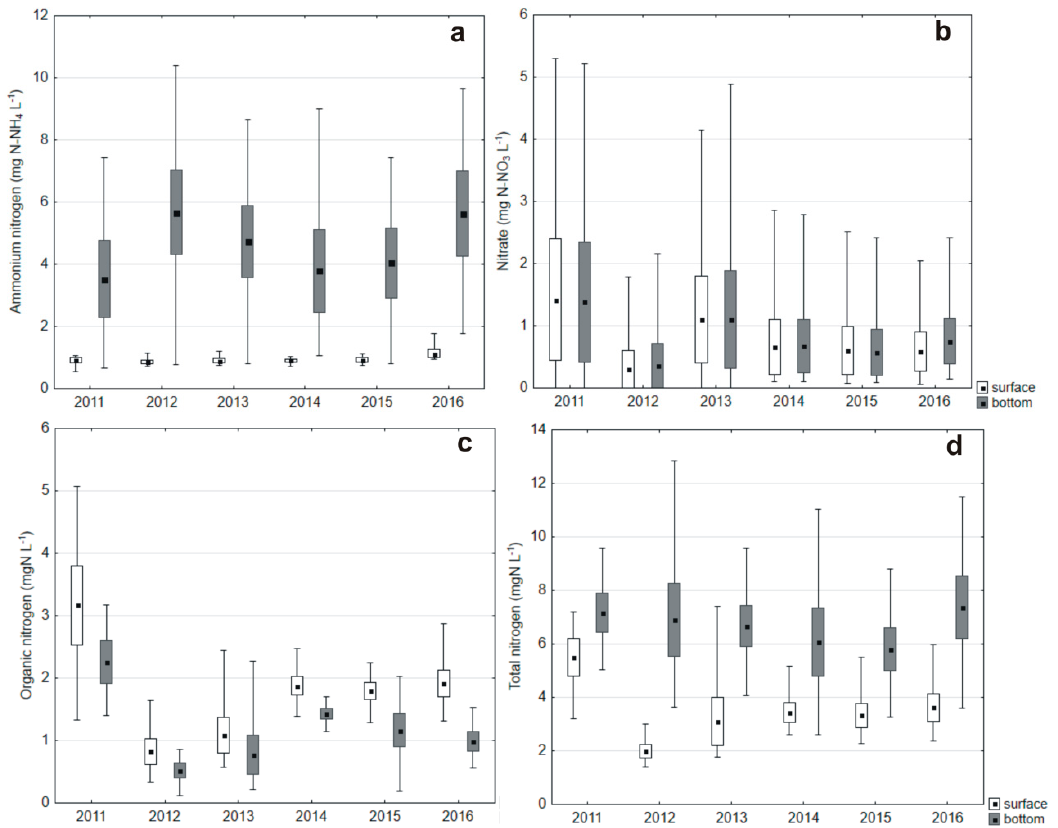
Figure 6. The mean, minimum and maximum concentrations of ammonium nitrogen ( a ), nitrate